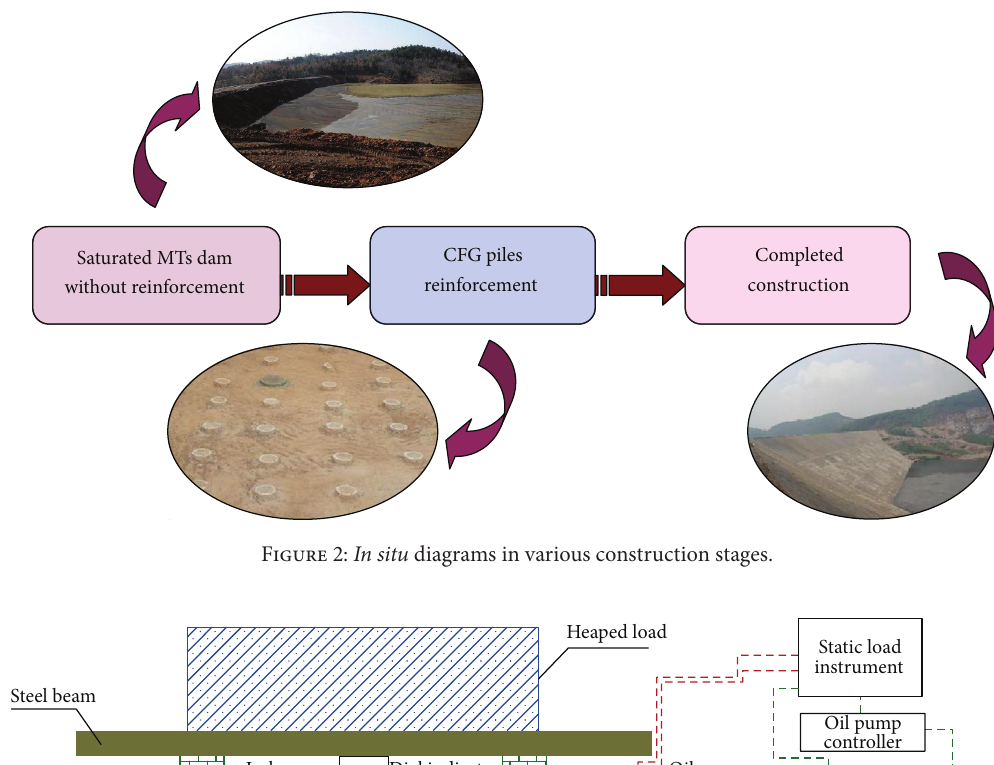
Figure 3: Diagram of static load test of composite